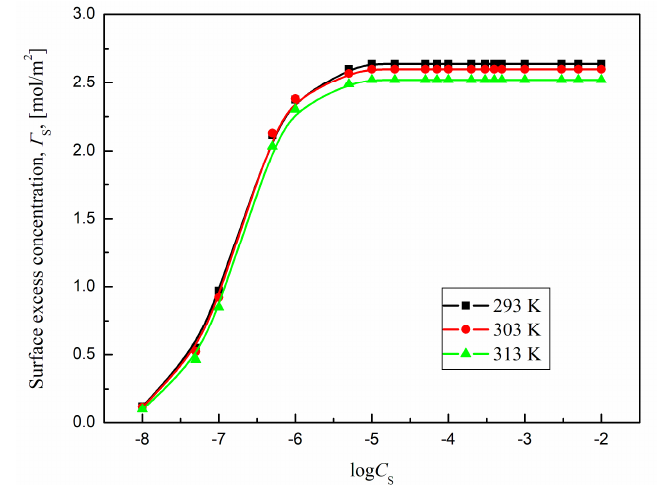
Figure 11. TS-OE12 Gibbs surface excess concentration ( Γ S ) at 298 K, 303 K and 313 K vs. the logarithm of surfactant concentration (log C S ).